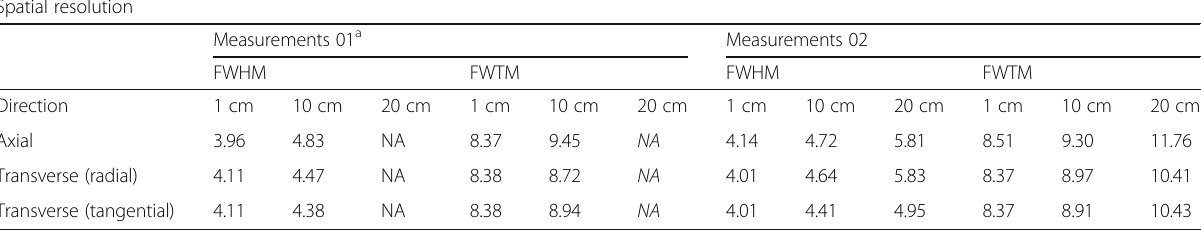
Table 1 NEMA spatial resolution of the dPET system Spatial